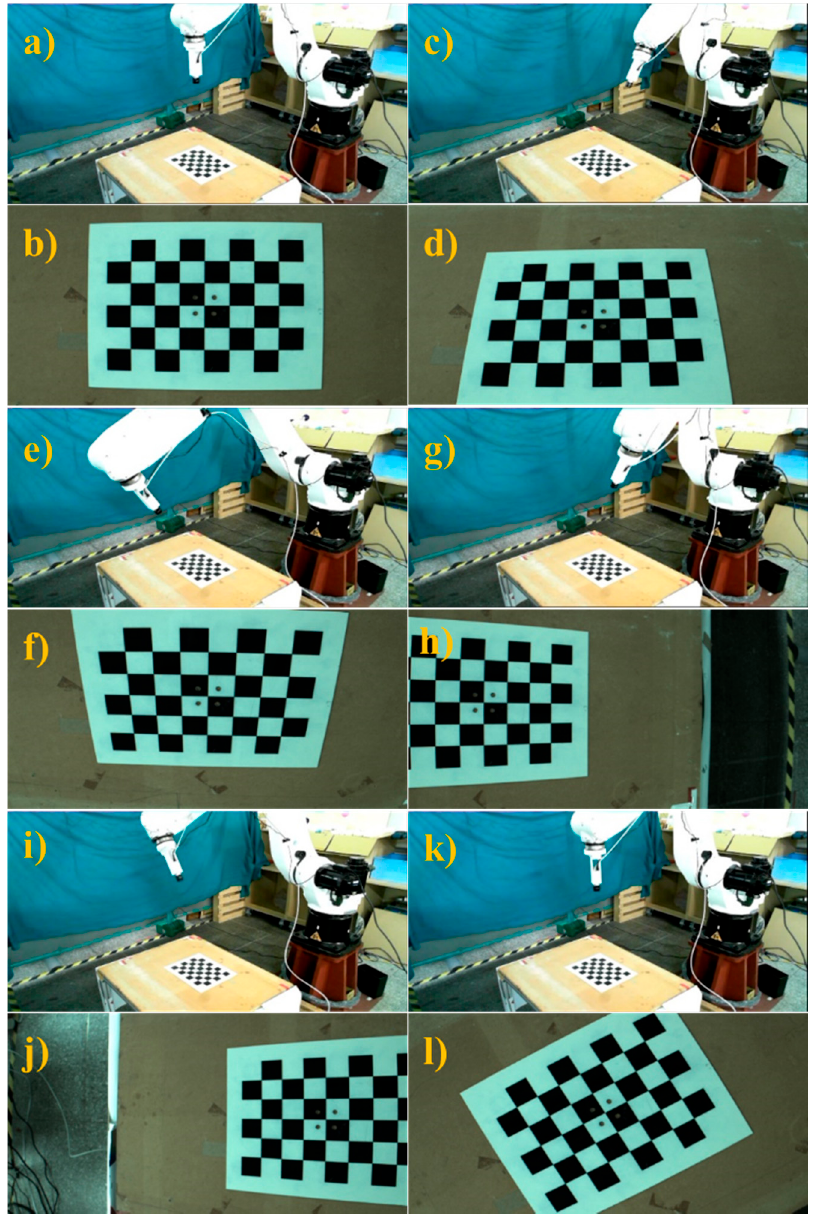
Figure 7. Six different robot positions for automatic hand–eye calibration. ( a ) 1st robot position, ( b ) image w.r.t. 1st position, ( c ) 2nd robot position, ( d ) image w.r.t. 2nd position, ( e ) 3rd robot position, ( f ) image w.r.t. 3rd position, ( g ) 4th robot position, ( h ) image w.r.t. 4th position, ( i ) 5th robot position, ( j ) image w.r.t. 5th position, ( k ) 6th robot position, ( l ) image w.r.t. 6th position. Table 2. The six different positions of the robot end-effector relative to the initial